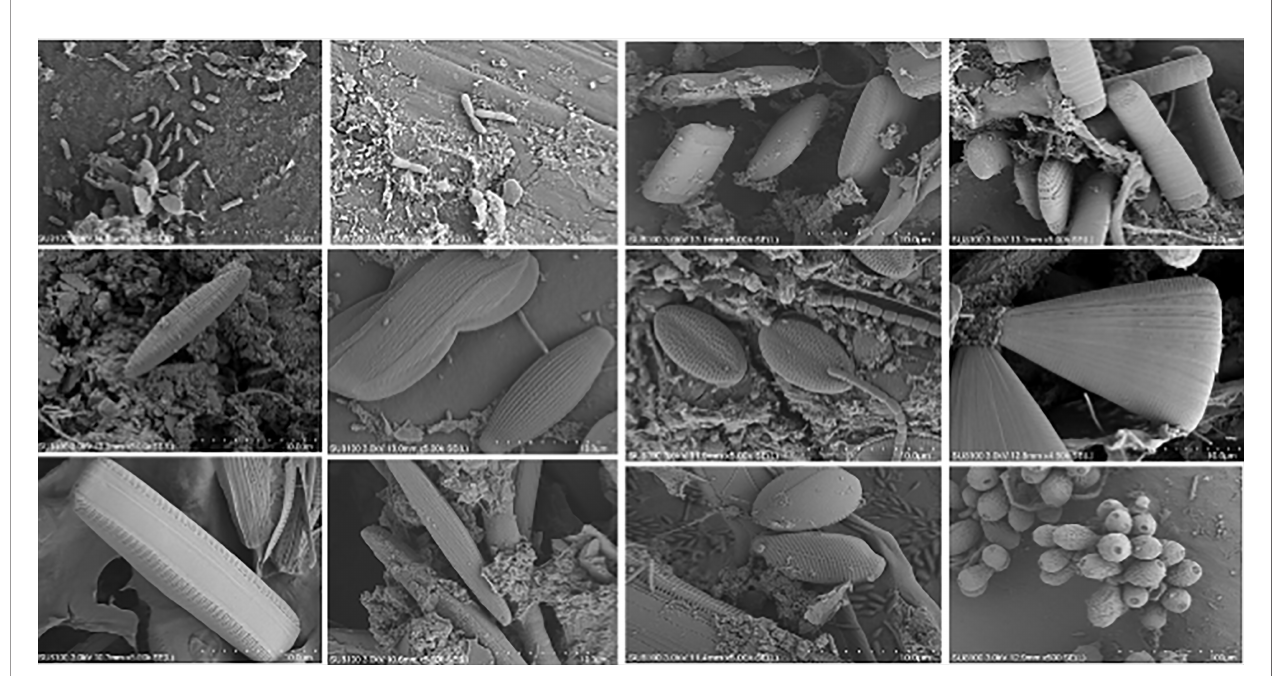
FIGURE 2 | Examples of microbial community on plastics samples using scanning electron microscopy.